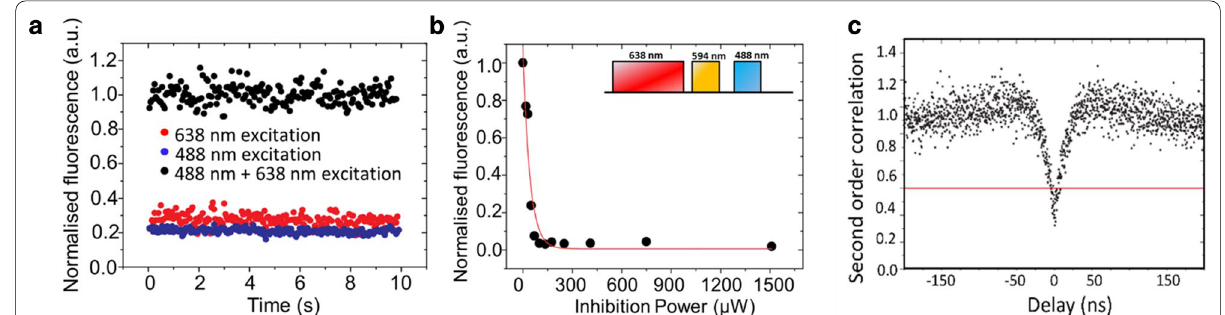
Fig. 2 a The fluorescence of a single NV − centre based on 488 nm and 638 nm excitation. The detected fluorescence increases when both lasers simultaneously excite the NV − centre. b Fluorescence dependence on depletion power. An illustration of the pulse sequence is shown in the inset. Fluorescence is detected only when the probe laser at 594 nm is on. c Antibunching curve of the NV − centre showing a second-order correlation function < 0.5 a zero-delay